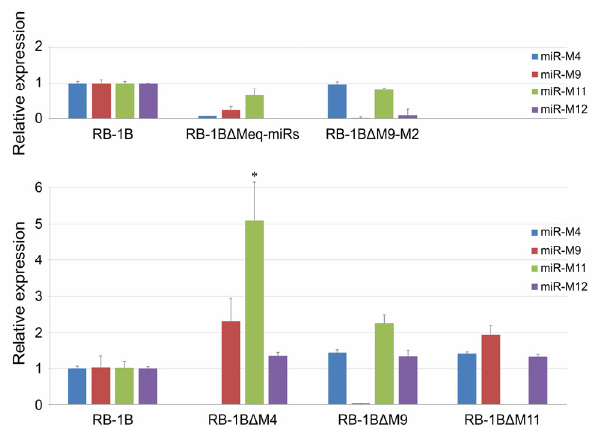
Figure 5. Relative expression levels of miRNAs in parental or mutated RB-1B-infected CEF cells. Asterisk (*) indicates statistically significant di ff erence between miRNA-knocked out (miR-KO) mutant virus and parental RB-1B. *, p <